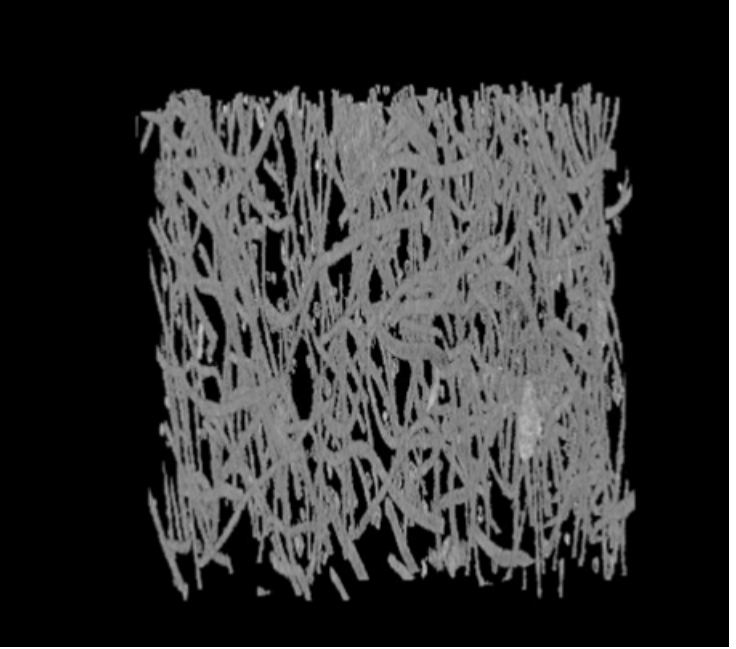
Figure 11. Computer simulation results of 3Dmed-reconstructed polyester short fibers.